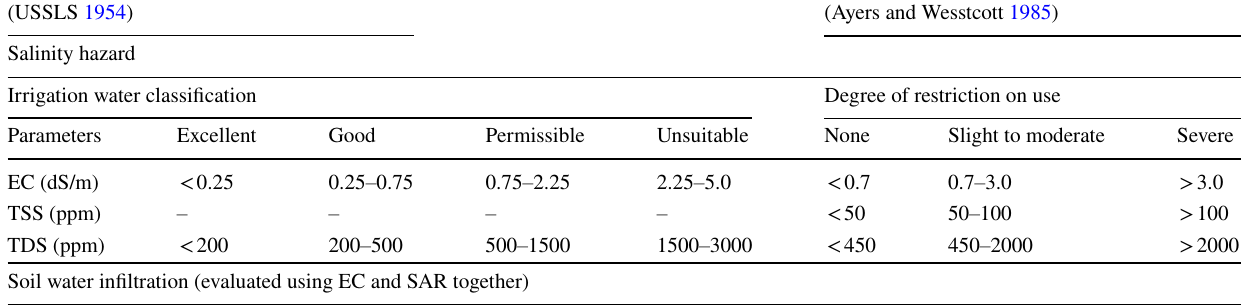
Table 1 Water quality classes for agricultural irrigation (Ayers and Wesstcott 1985), (USSLS 1954) (USSLS